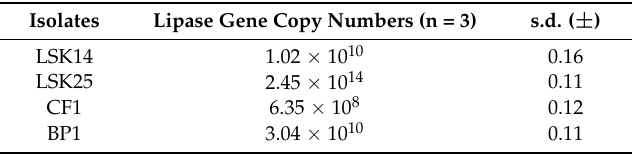
Table 1. Lipase gene copy quantification using qPCR.